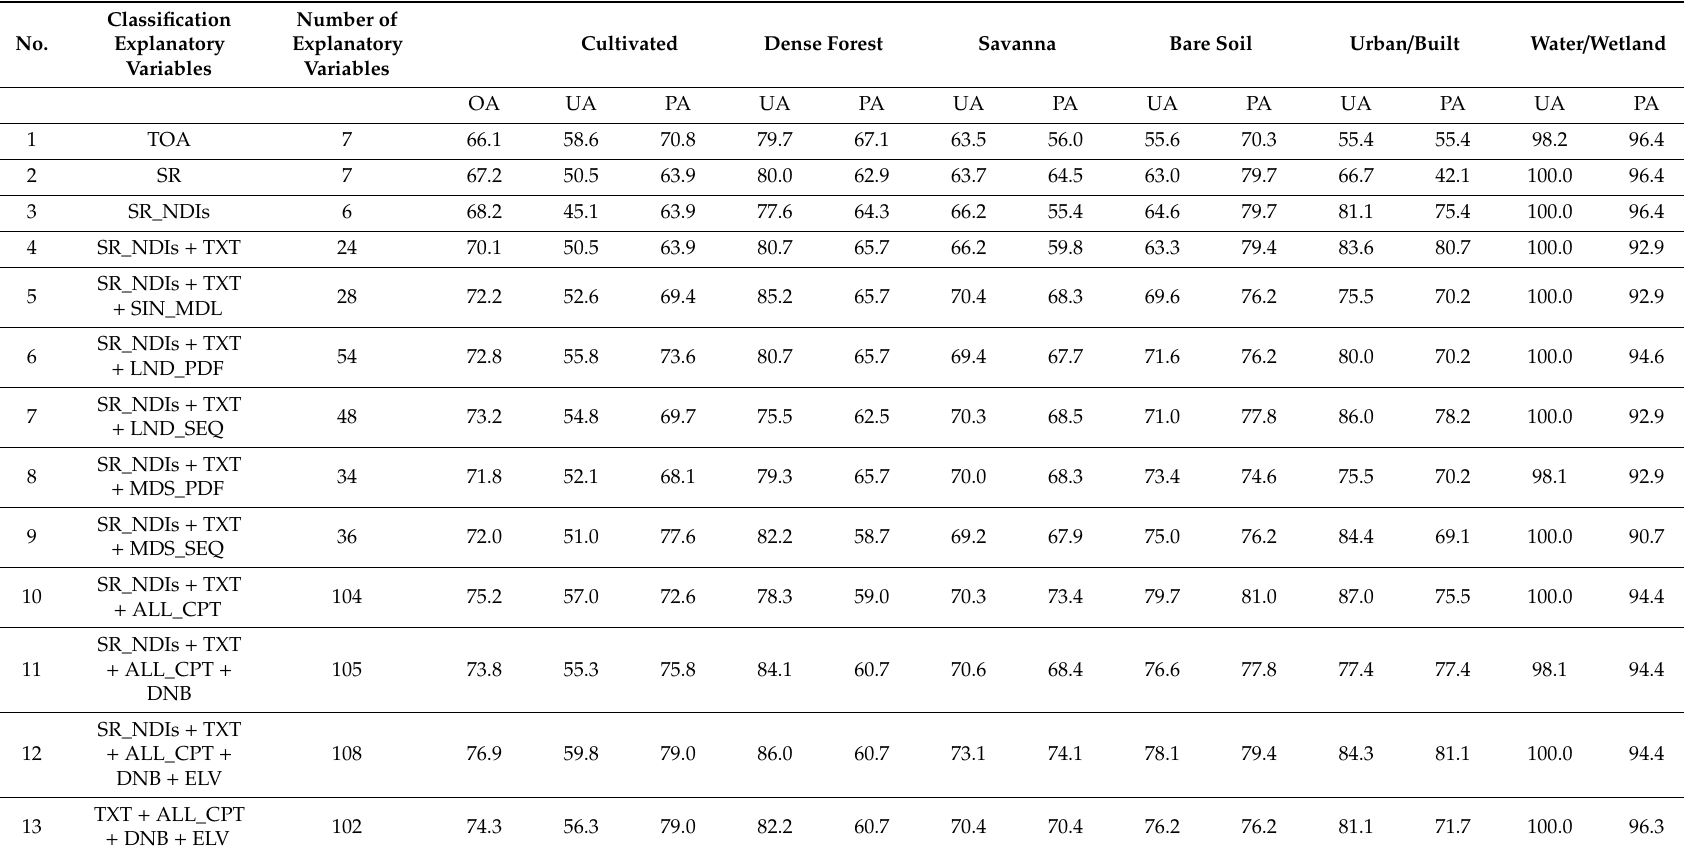
Table 2. Overall and class-specific accuracies (%) of classifications based on di ff erent combinations of input